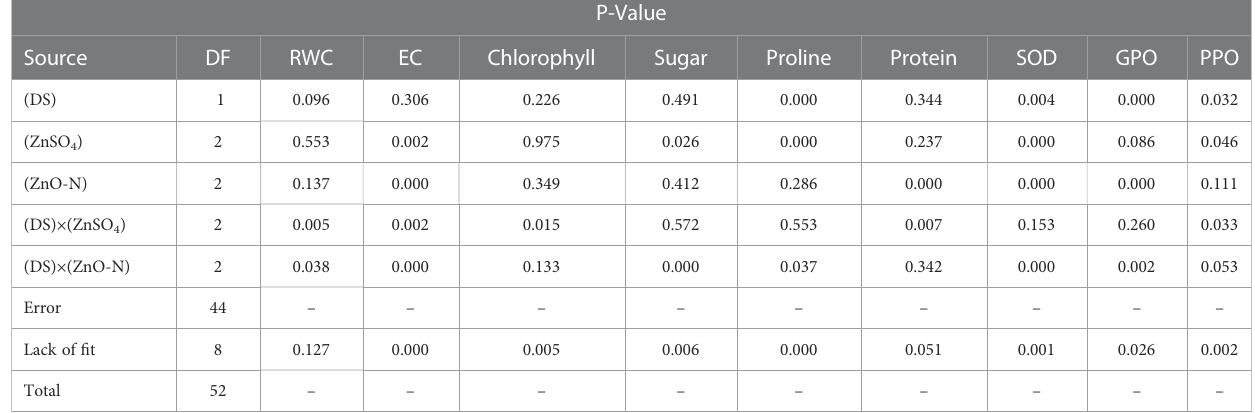
TABLE 1 Analysis variance of physiological and biochemical traits in treated D. kotschyi by ZnSO 4 and ZnO-N under drought